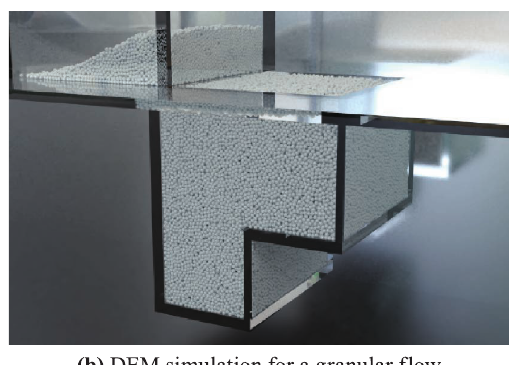
Fig. 4 Effect of air flow on the powder